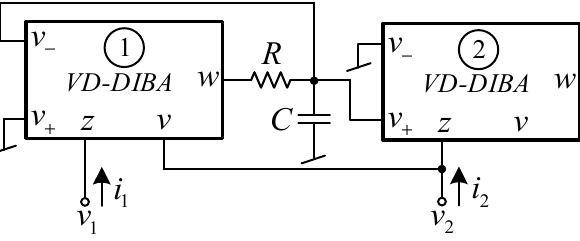
Figure 16. The floating series inductance-resistance simulator based on VD-DIBAs.